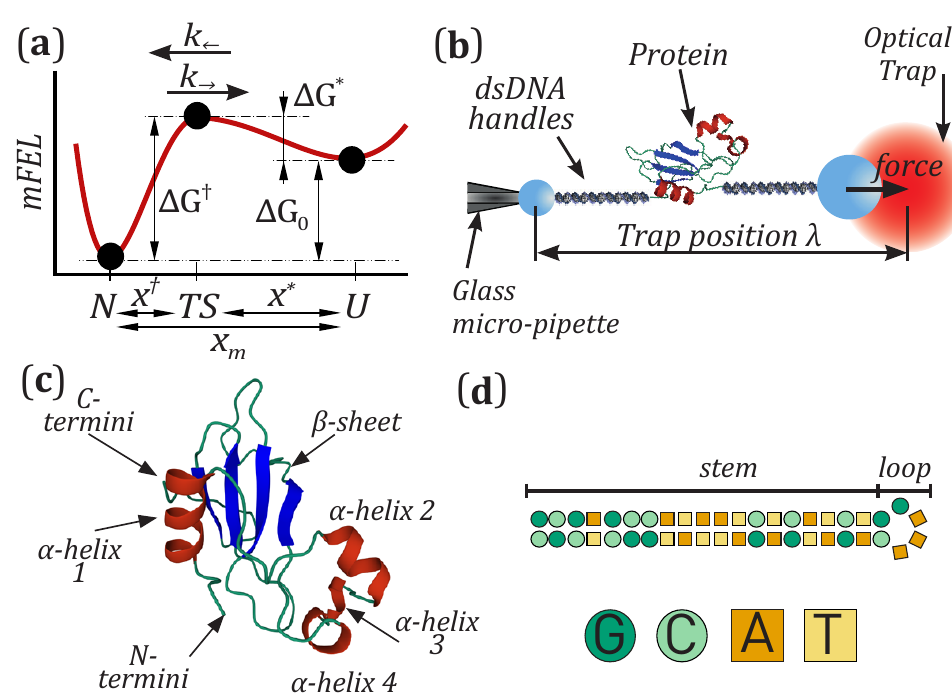
Figure 1. Single-molecule experiments. ( a ) Illustration of the mFEL of barnase. A kinetic barrier (located at the transition state TS ) mediates transitions between N and U . ∆ G 0 is the free energy difference between N and U , whereas ∆ G † and ∆ G ∗ are the kinetic barriers relative to N and U , respectively. ( b ) Illustration of the single-molecule experimental setup. The optical trap measures the force f applied to the ends of the molecular construct. The distance between the optical trap and the pipette, λ , denotes the control parameter of the experiment. ( c ) Structure of the protein barnase [40]. ( d ) Sequence of the DNA hairpin